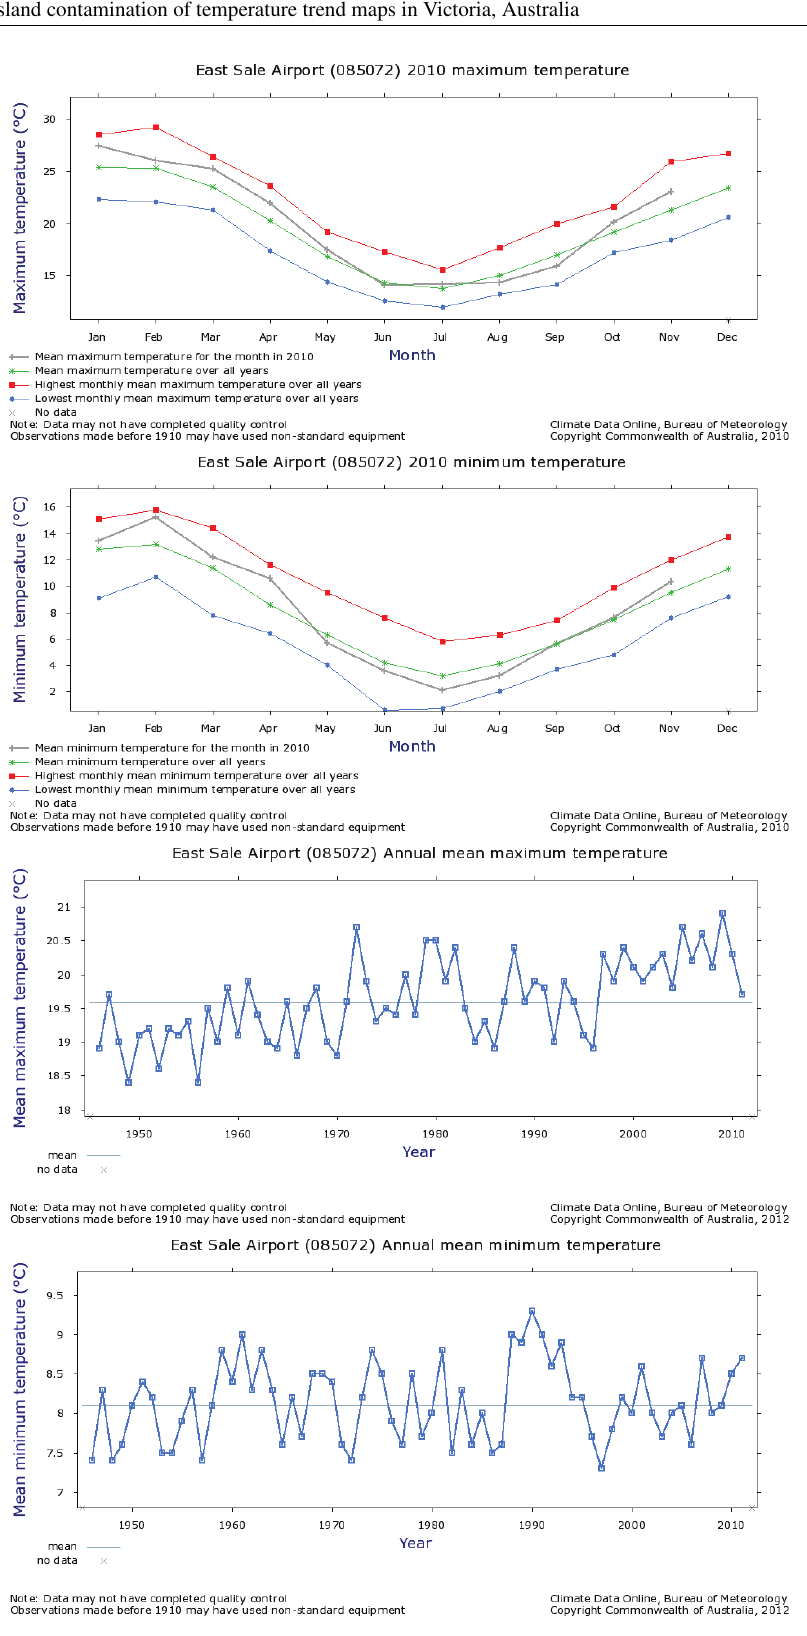
Figure 17. Australian Government Bureau of Meteorology temperature graphs for historical locations in Victoria, Aus-